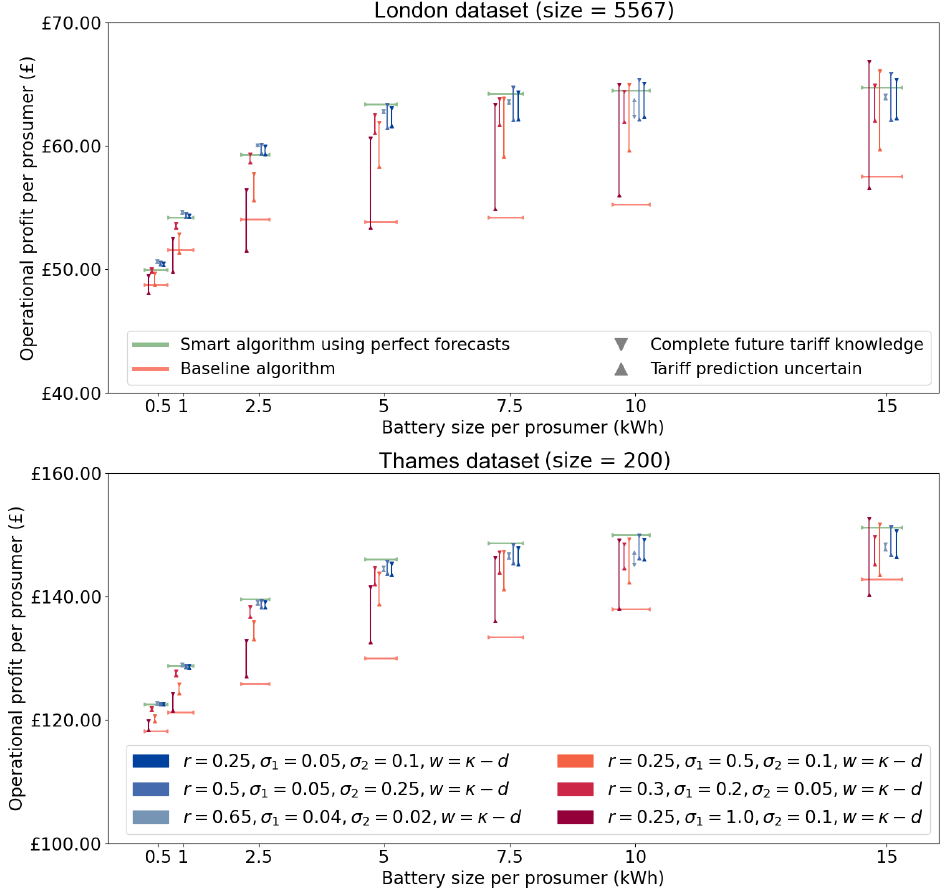
Figure 13. High-level comparison between operational profits of the baseline algorithm and smart algorithm for the average prosumer using various battery sizes and lookahead amounts with un- certain forecasts based on converging and diverging margins. The legend in each graph applies to both graphs.